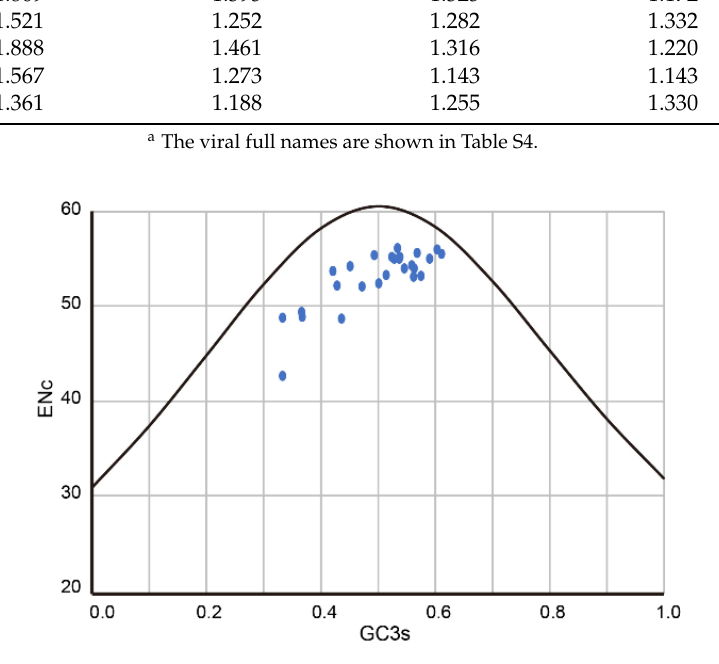
Figure 6. ENc values plotted against GC3s. The blue circles represent individual fusariviruses.